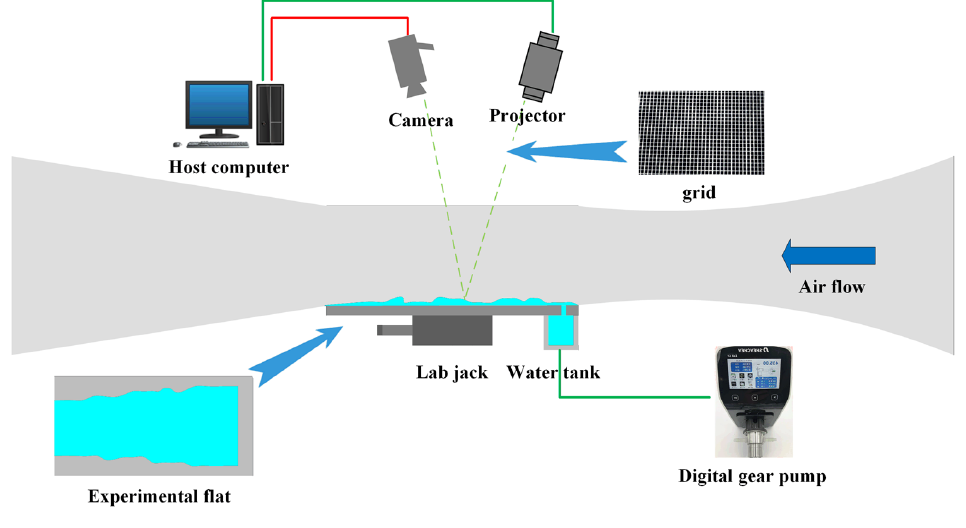
Figure 1. The water film measurement system [16].